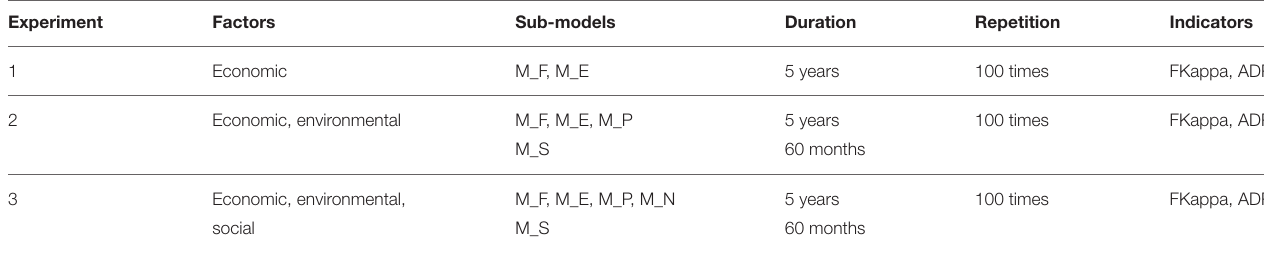
TABLE 4 | Description of